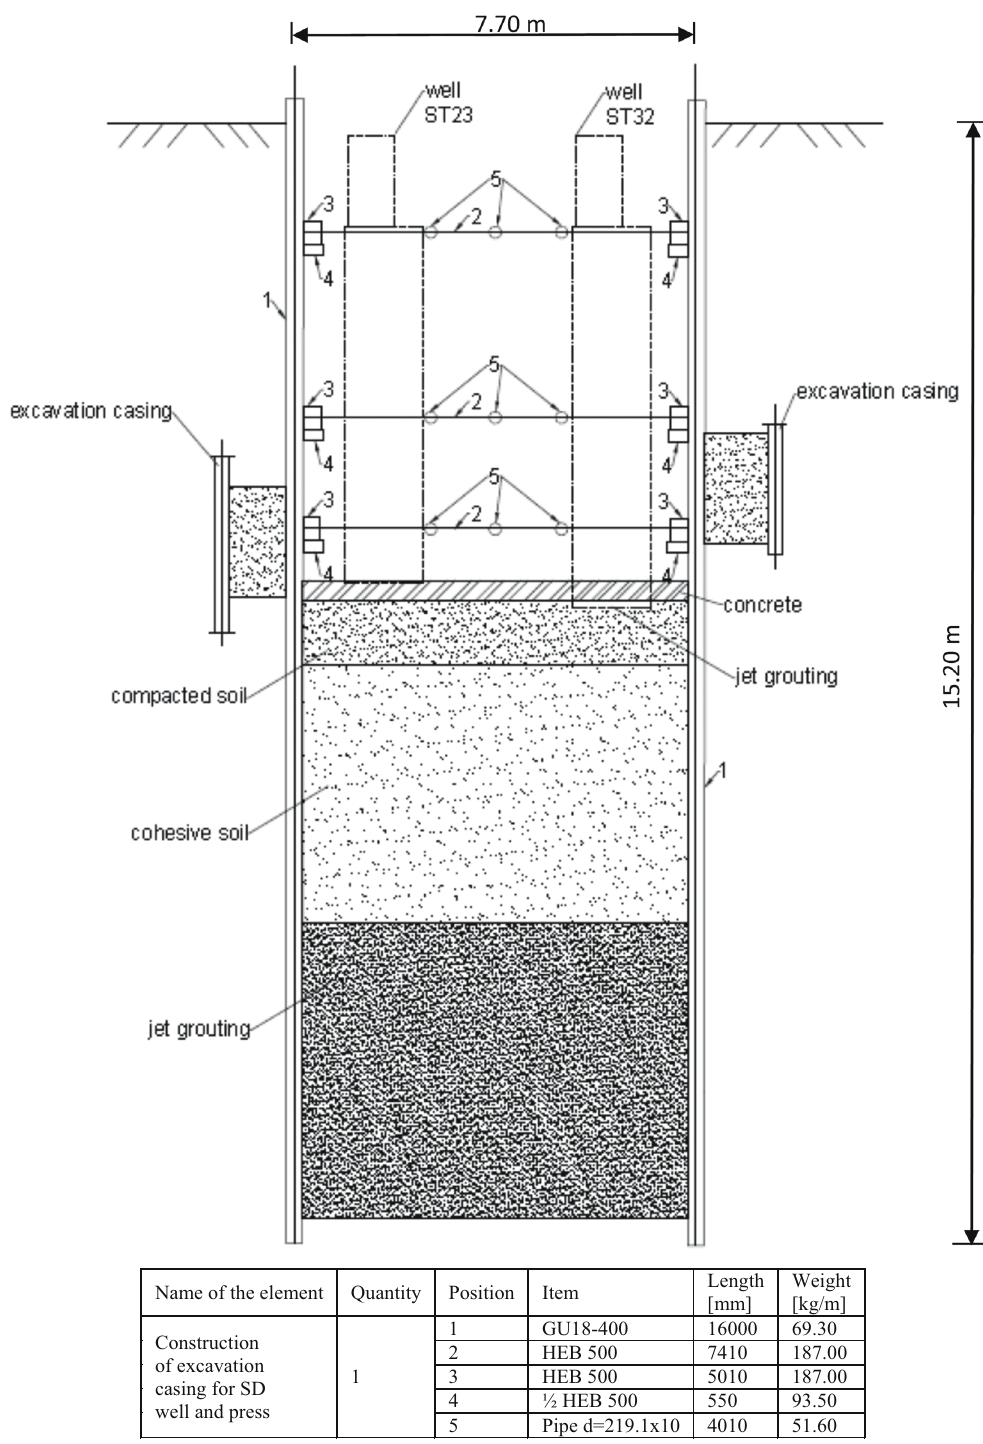
Figure 3: An example of a calculation scheme for the S1 trench